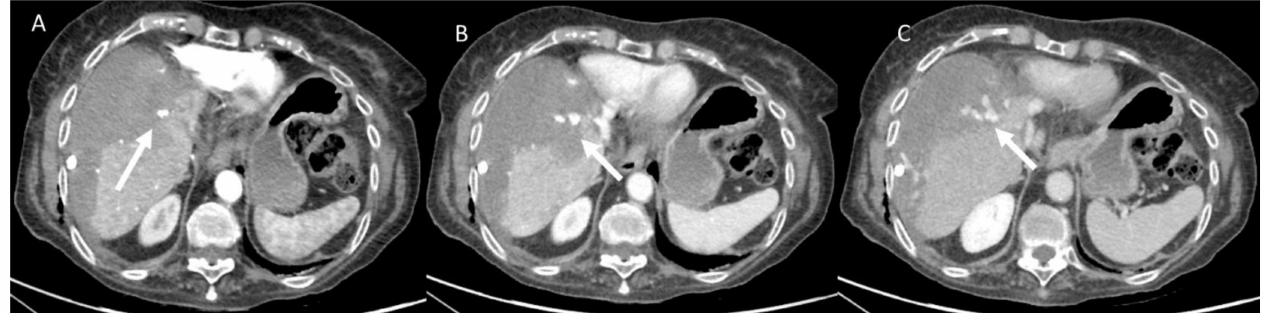
Figure 1. Woman 67 years at 1-day follow-up after radio frequency ablation of liver metastases. CT